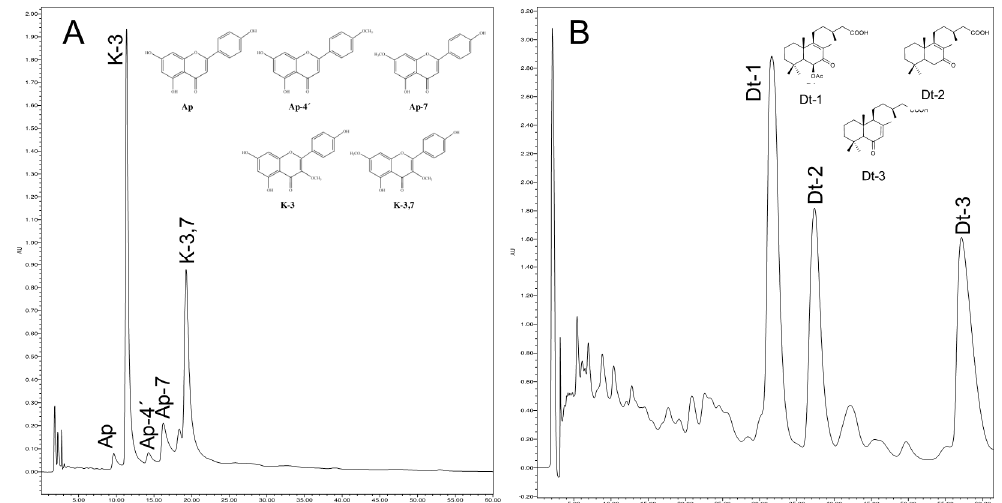
Figure 6. Chemical structures and HPLC chromatograms at 350 nm of flavonoids ( A ): Ap: